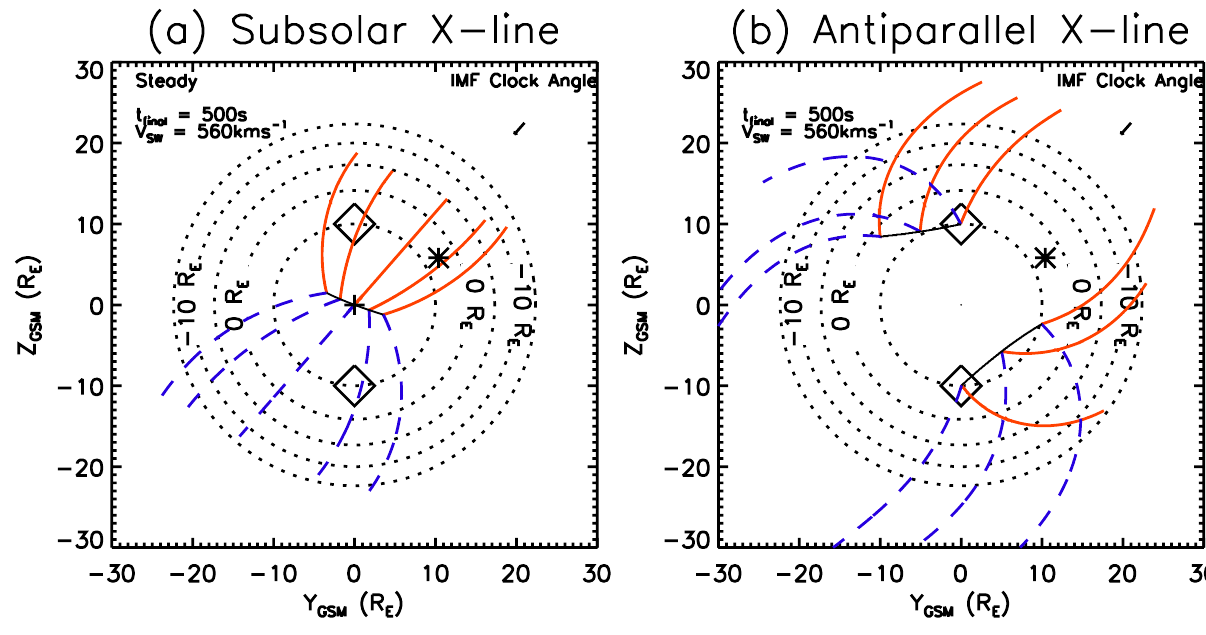
Fig. 6. Motion of the opened field lines predicted by the Cooling model. Field lines connected to the Northern Hemisphere are shown in red and field lines connected to the Southern Hemisphere are shown in blue. In (a) reconnection is initiated near the subsolar point. In (b) reconnection is initiated in region of highest shear in the Northern and Southern Hemisphere. The position of Cluster is shown with an asterisk. The diamond show the location of the cusp. The dotted lines are contours in X GSM .